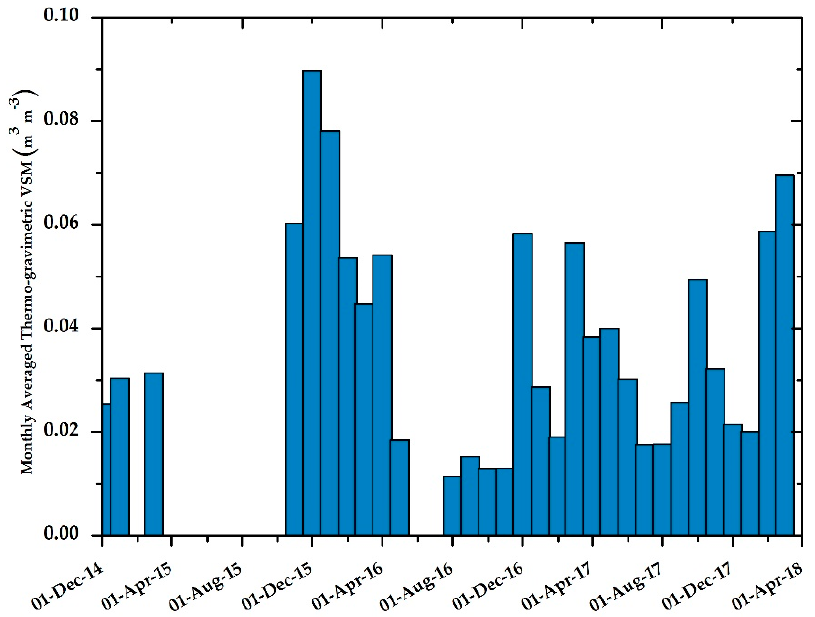
Figure 2. Monthly average thermogravimetric VSM over validation test site (36 km × 36 km) from 83 field visits.